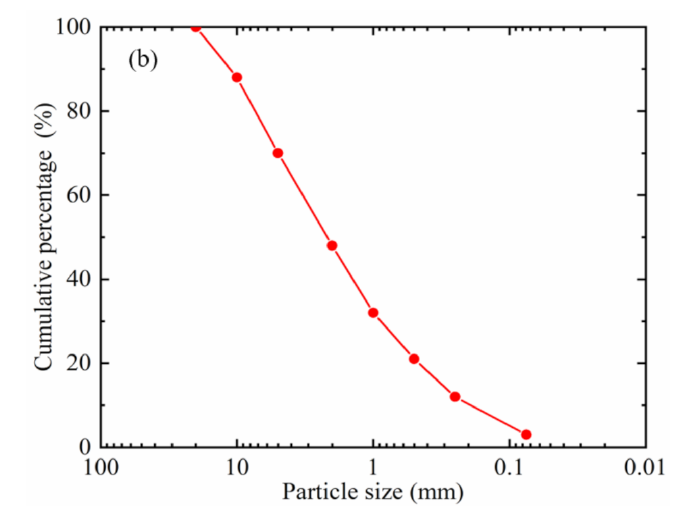
Figure 2. Particle characteristics. ( a ) Photograph of the particle size. ( b ) Cumulative gradation curve.